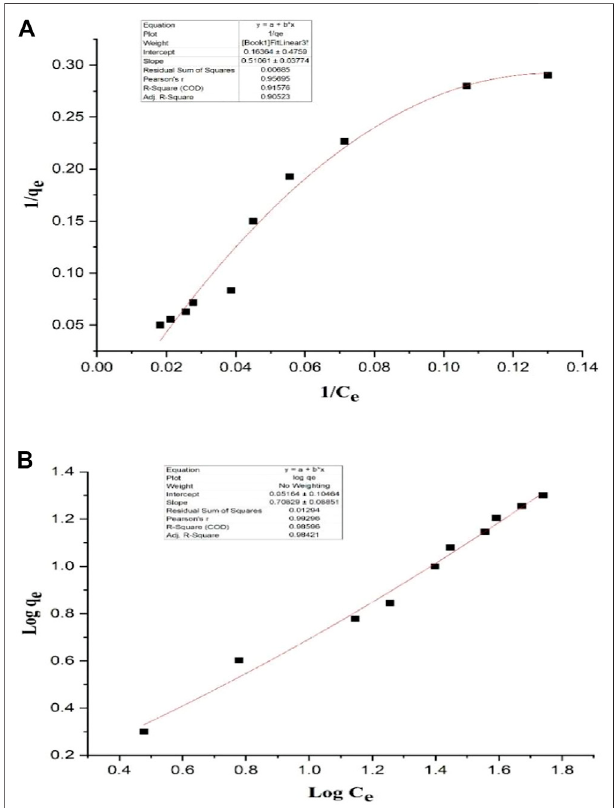
FIGURE 1 | (A, B) Adsorption isotherm of Pb binding by L. acidophilus KLDS